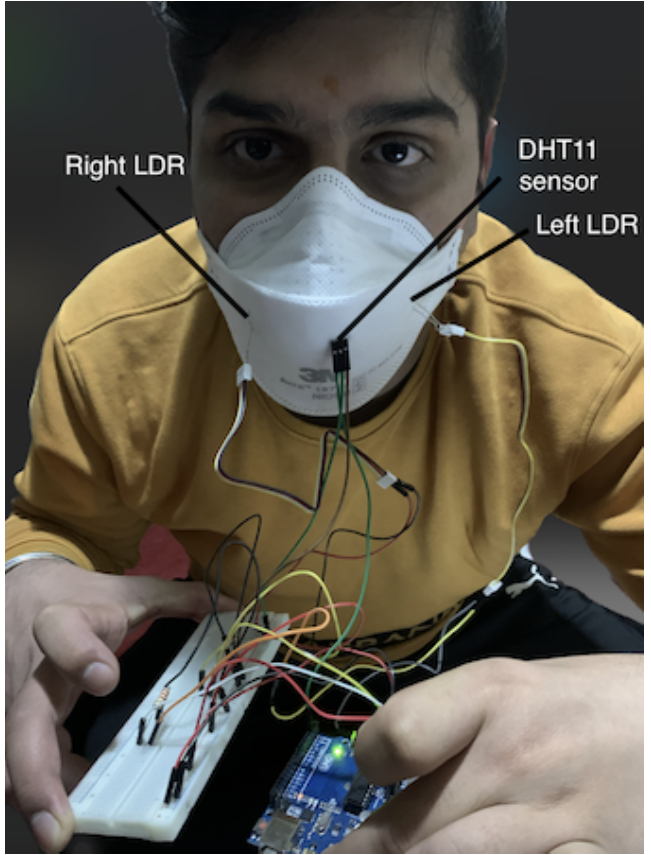
Figure 9. Setup worn by